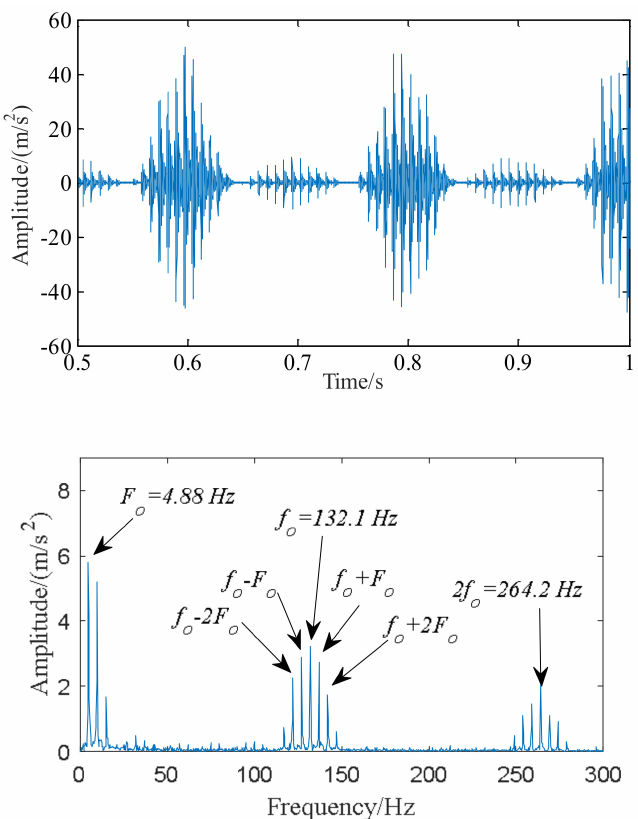
Figure 13. Time–domain signal and envelope spectrum of OR fault (numerical